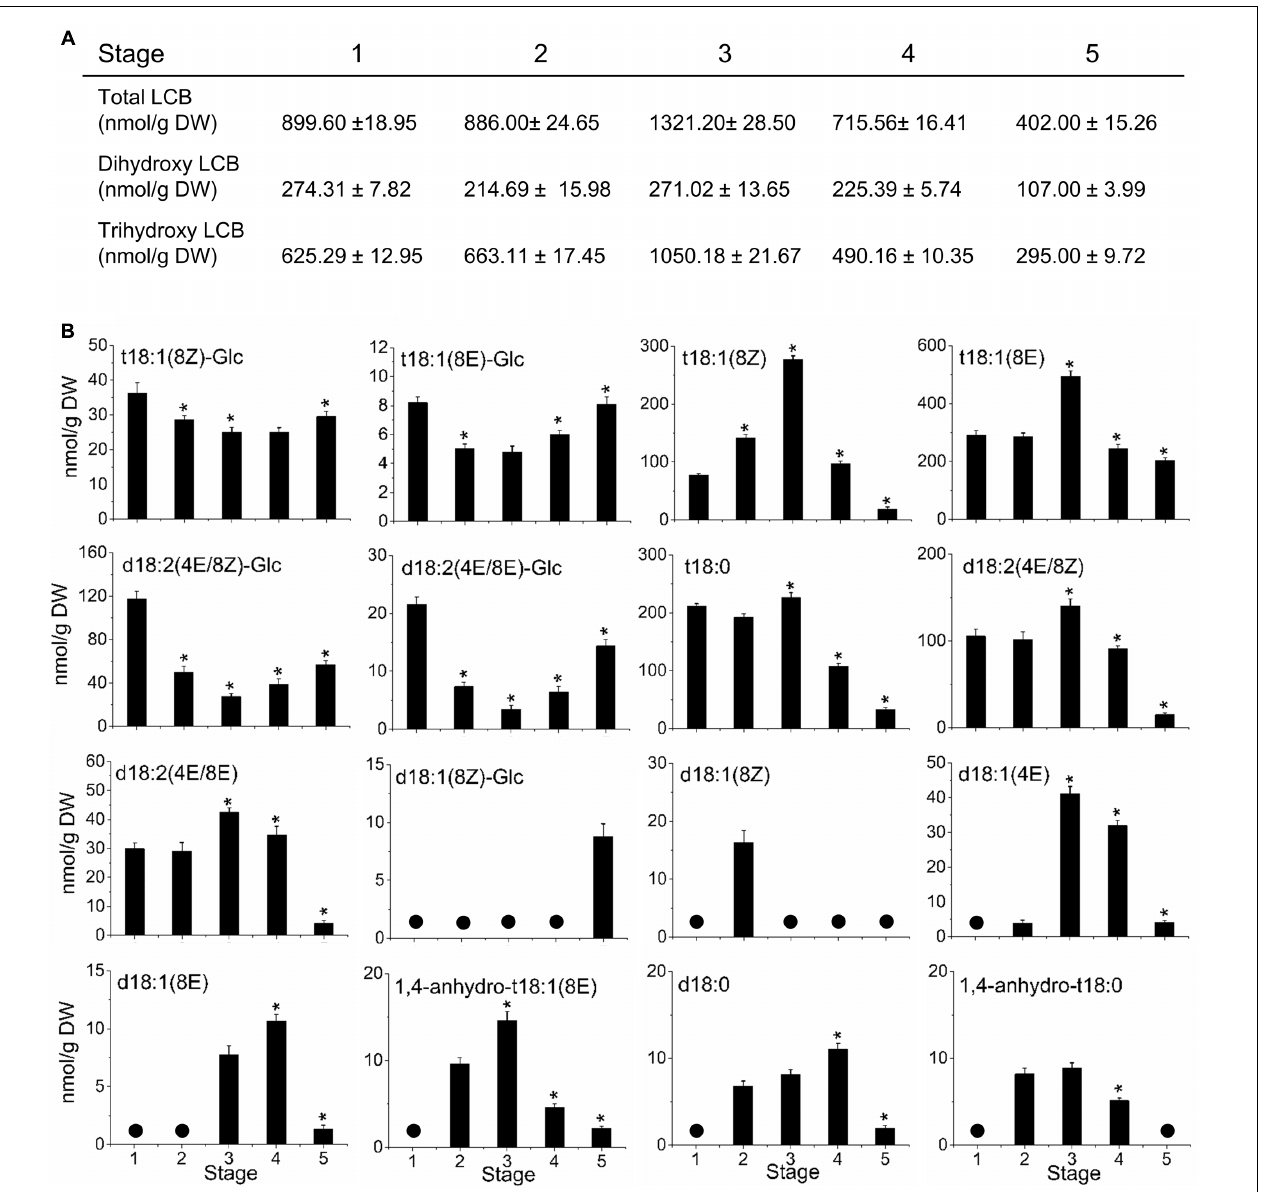
FIGURE 6 | Sphingolipid content and composition of olive fruit during development. (A) Content of LCB hydrolyzed from total sphingolipids and relative content of dihydroxy or trihydroxy LCBs in total extracts. (B) Profiles of LCBs from olive fruit at different stages of development. Data are means of three independent biological repeats. Statistically significant differences from the preceding point based on unpaired Student’s t -test at P < 0.05 are denoted by asterisks. The molecular species not detected are denoted by a circle ( ). d18:1(8 E )-Glc and 1,4-anhydro-t18:1(8 Z ) were undetectable in olive fruit at five different stages of (cid:32)